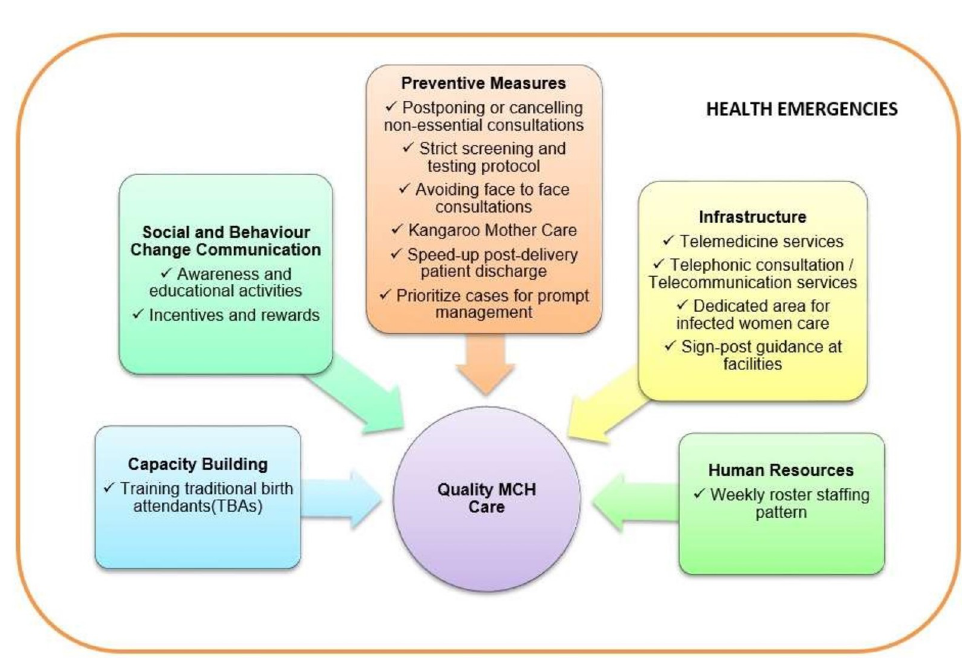
Fig 5. Framework for ensuring quality MCH care services during pandemic related health emergencies (Zika, Ebola and